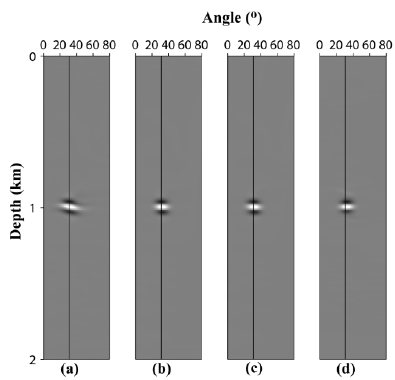
Figure 2. Angle gathers at 3 km of which source at 2.4 km of the constant velocity model in Figure 1b. ( a ) Method 1, ( b ) Method 2, ( c ) Method 3, ( d ) Method 4.